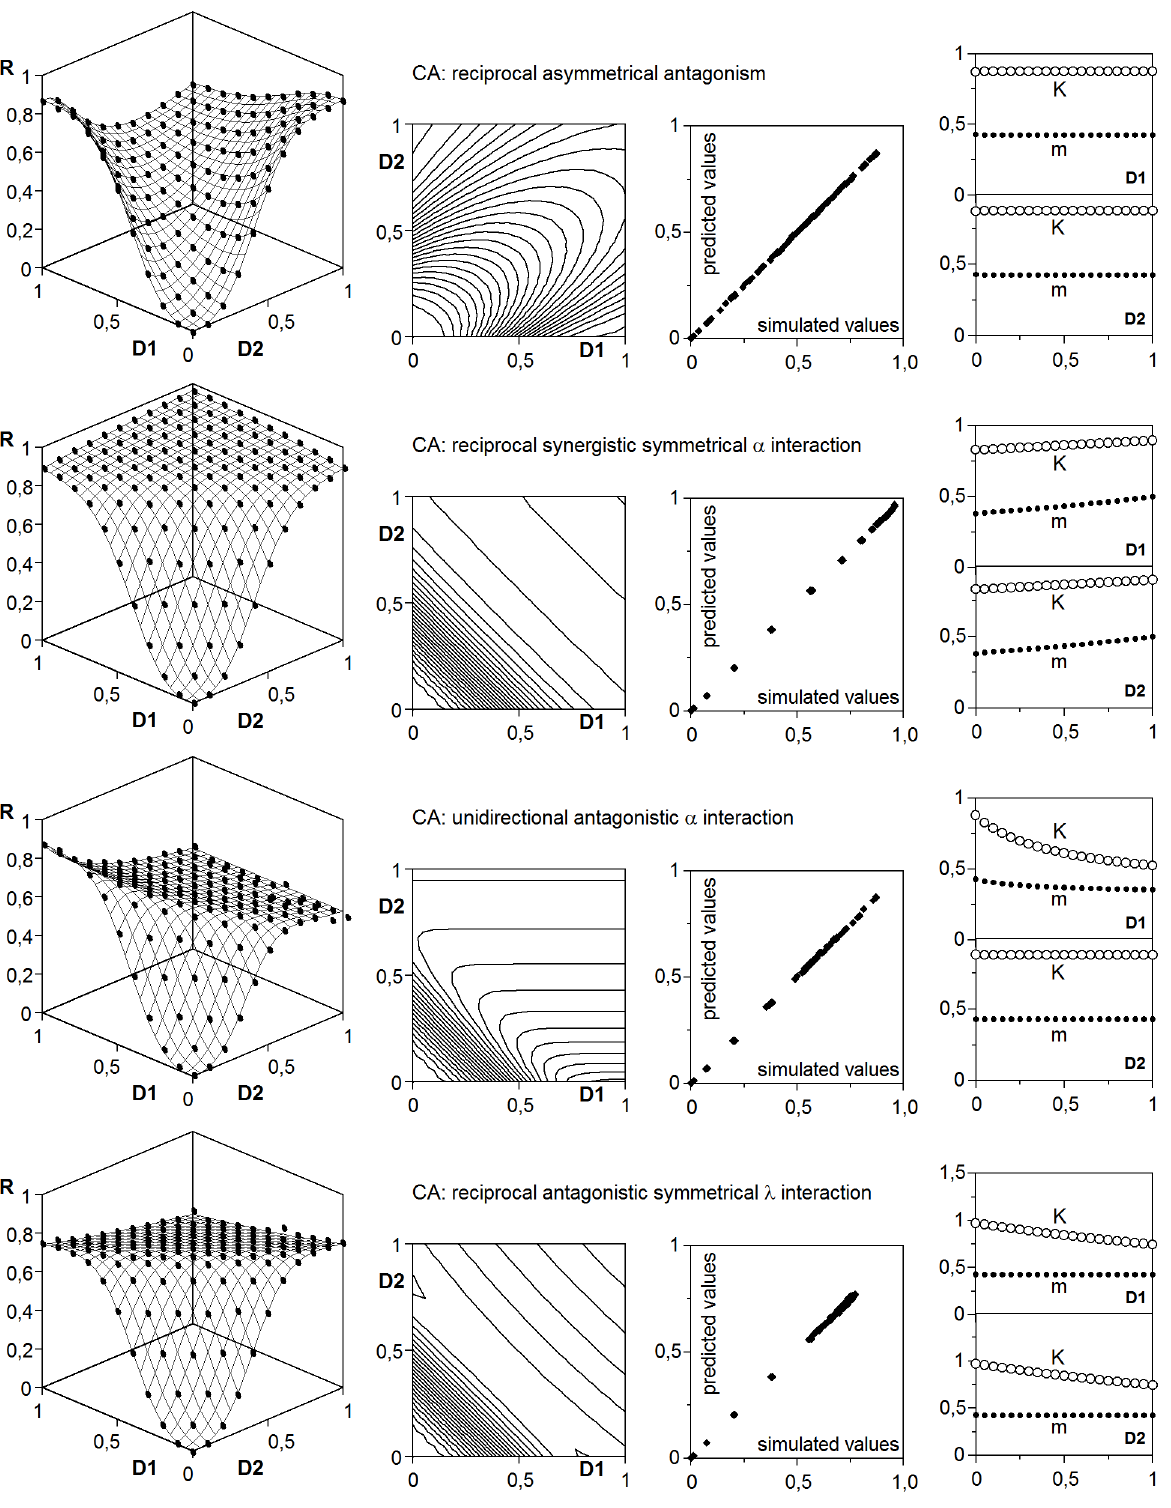
Figure 9. More examples of joint responses to two effectors under CA mode of action. Concrete types of interactions are specified and adjusted to the generalized model (32). Keys and graphic criteria as in Figure 6. See also Table 5.